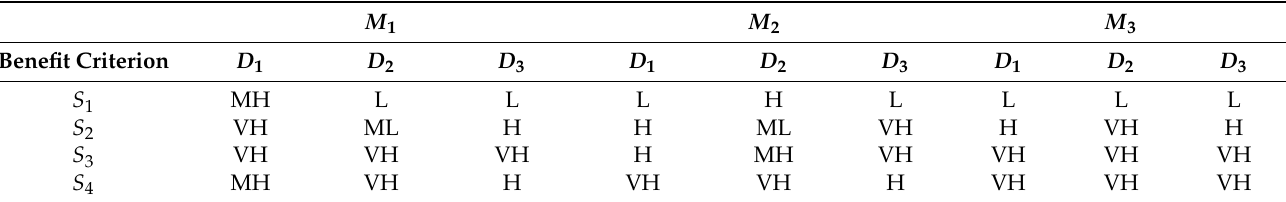
Table 6. Weight of each criterion by the decision-makers from M 1 , M 2 , and M 3 . M 1 M 2 M